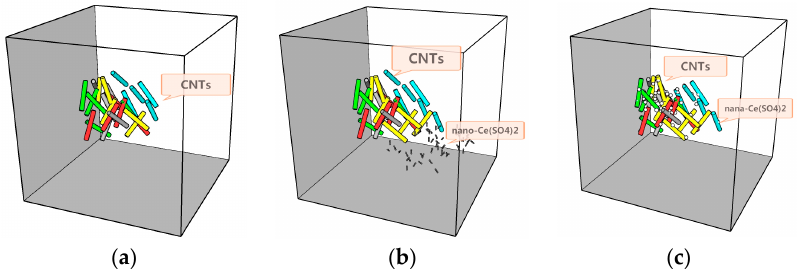
Figure 6. Adsorption of nano-Ce(SO 4 ) 2 on the surface of CNTs. ( a ) without nano-Ce(SO 4 ) 2 , ( b ) with nano-Ce(SO 4 ) 2 , ( c ) nano-Ce(SO 4 ) 2 is adsorbed.